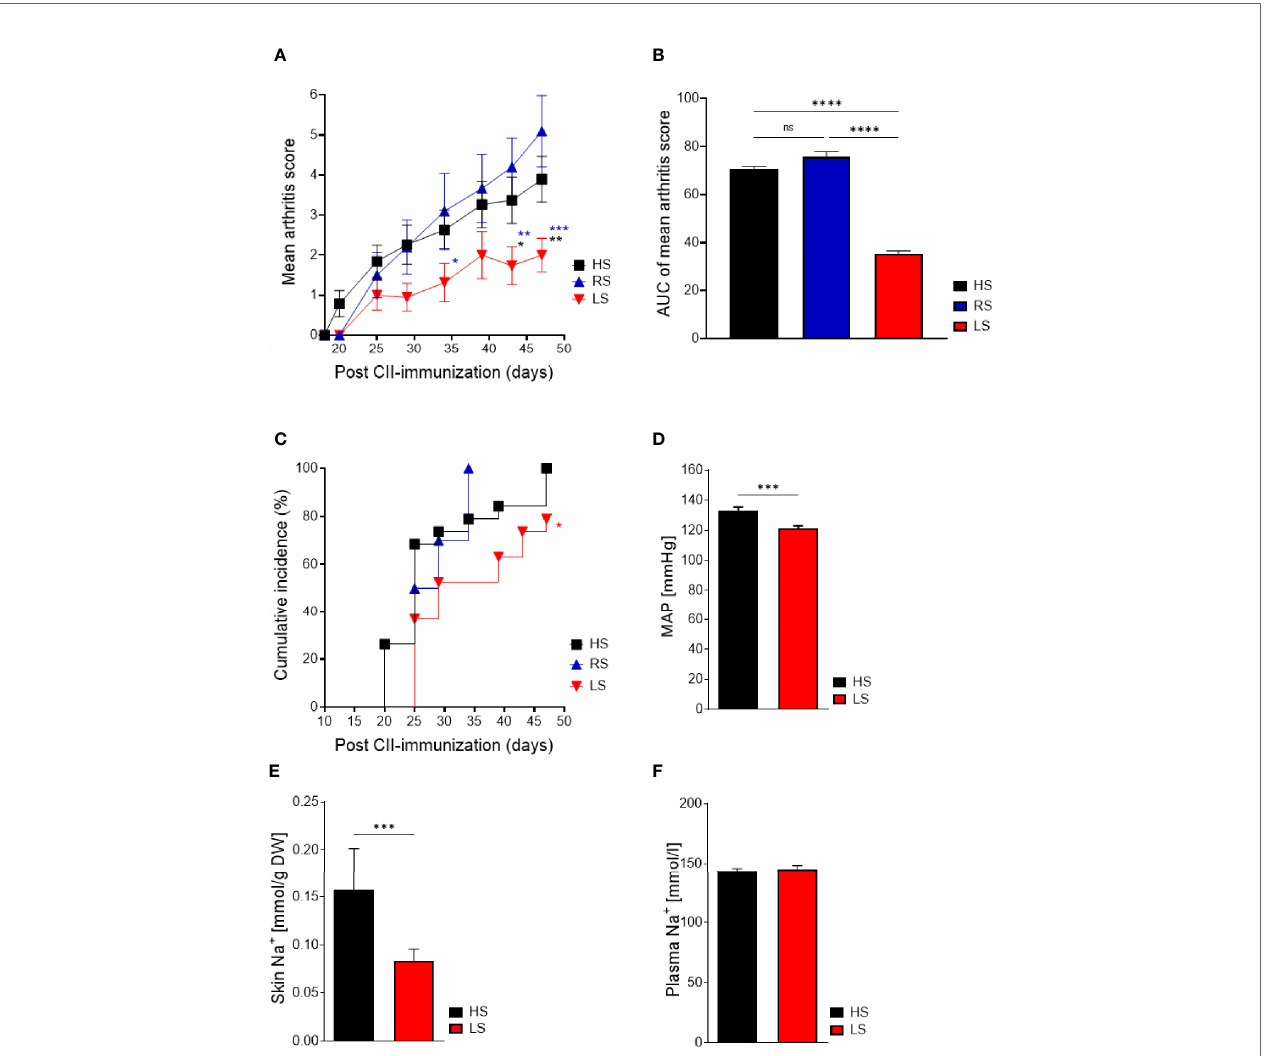
FIGURE 3 | Low-salt diet reduces severity and incidence of arthritis and salt-related effects in collagen-induced arthritis. Mice were exposed to low salt (LS), regular salt (RS), and high salt (HS) diets for 2 weeks before CII immunization and continued for further 47 days. (A) Mean arthritis score of CIA mice under respective diets (LS, n = 19; RS, n = 9; HS, n = 19). * p < 0.05, ** p < 0.01,*** p < 0.001; blue asterisk: LS versus RS, black asterisk: LS versus HS. p -values were calculated by two- way ANOVA followed by Bonferroni ’ s multiple comparisons test. (B) Area under curve of mean arthritis score. **** p < 0.0001. p -values were calculated by one-way ANOVA followed by Bonferroni ’ s multiple comparisons test. (C) Cumulative incidence of CIA with LS, RS, and HS diet (LS, n = 19; RS, n = 9; HS, n = 19). * p < 0.05, ns = non-signi fi cant. Kaplan – Meier method was used to calculate differences in incidences of experimental arthritis performing log rank (Mantel-Cox). (D) Blood pressure measurements of CIA mice kept under LS and HS diets. *** p < 0.001. (E) Levels of Na + (mmol/gr dry weight) in skin of CIA mice with LS and HS diets. *** p < 0.001 . (F) Plasma Na + levels (mmol/l). p -values were calculated by unpaired Student ’ s t -test (D – F) . All data were expressed as ±